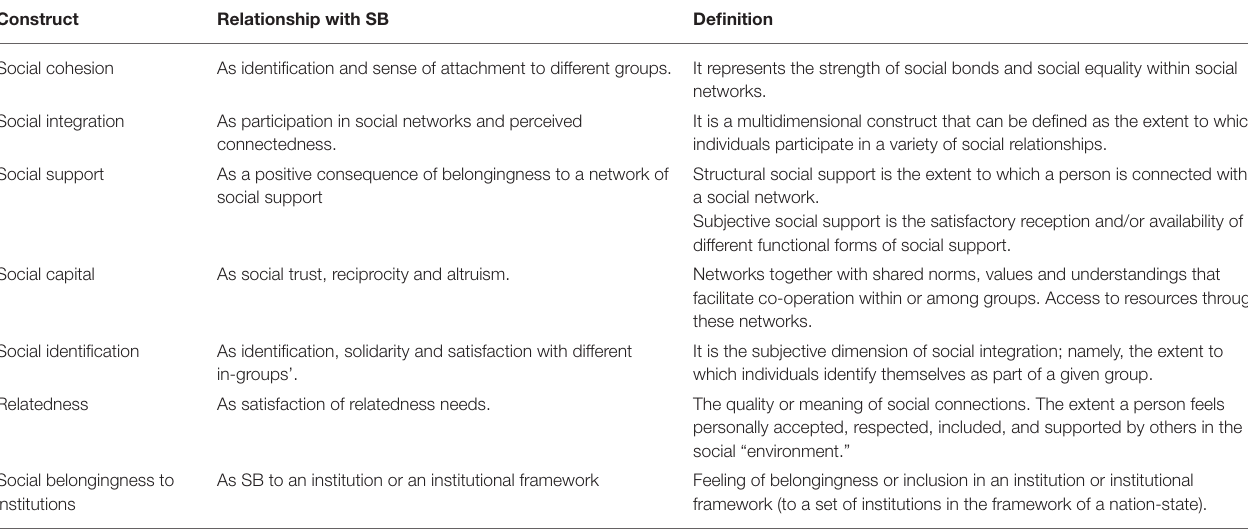
TABLE 1 | Concepts associated with Social Belongingness